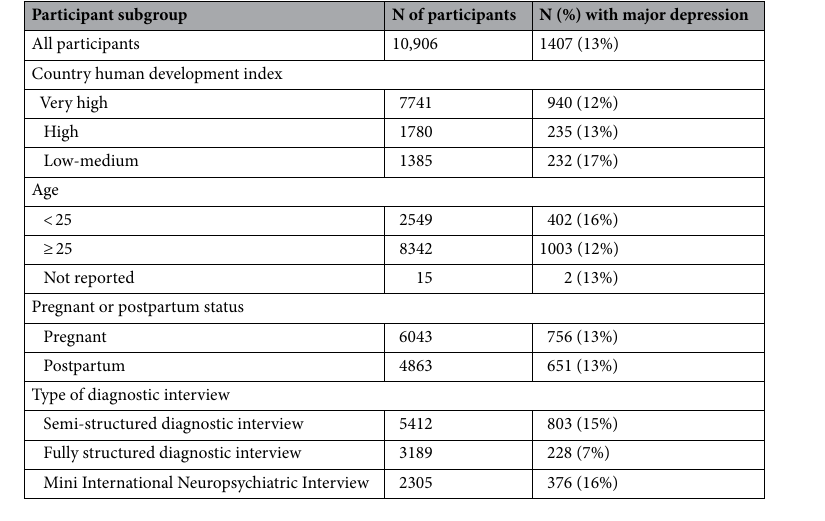
Table 1. Participant characteristics by subgroups.